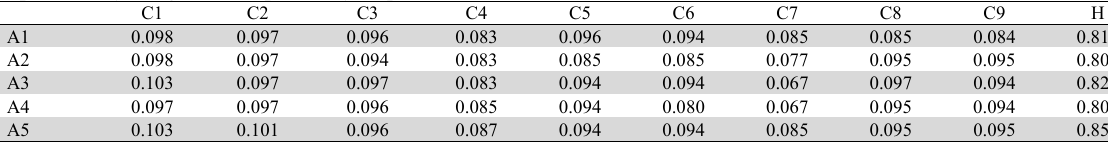
Exponentially weighted comparability sequence for the measures